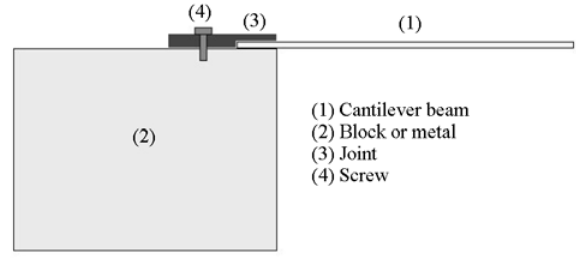
Figure 2. Details of specimens